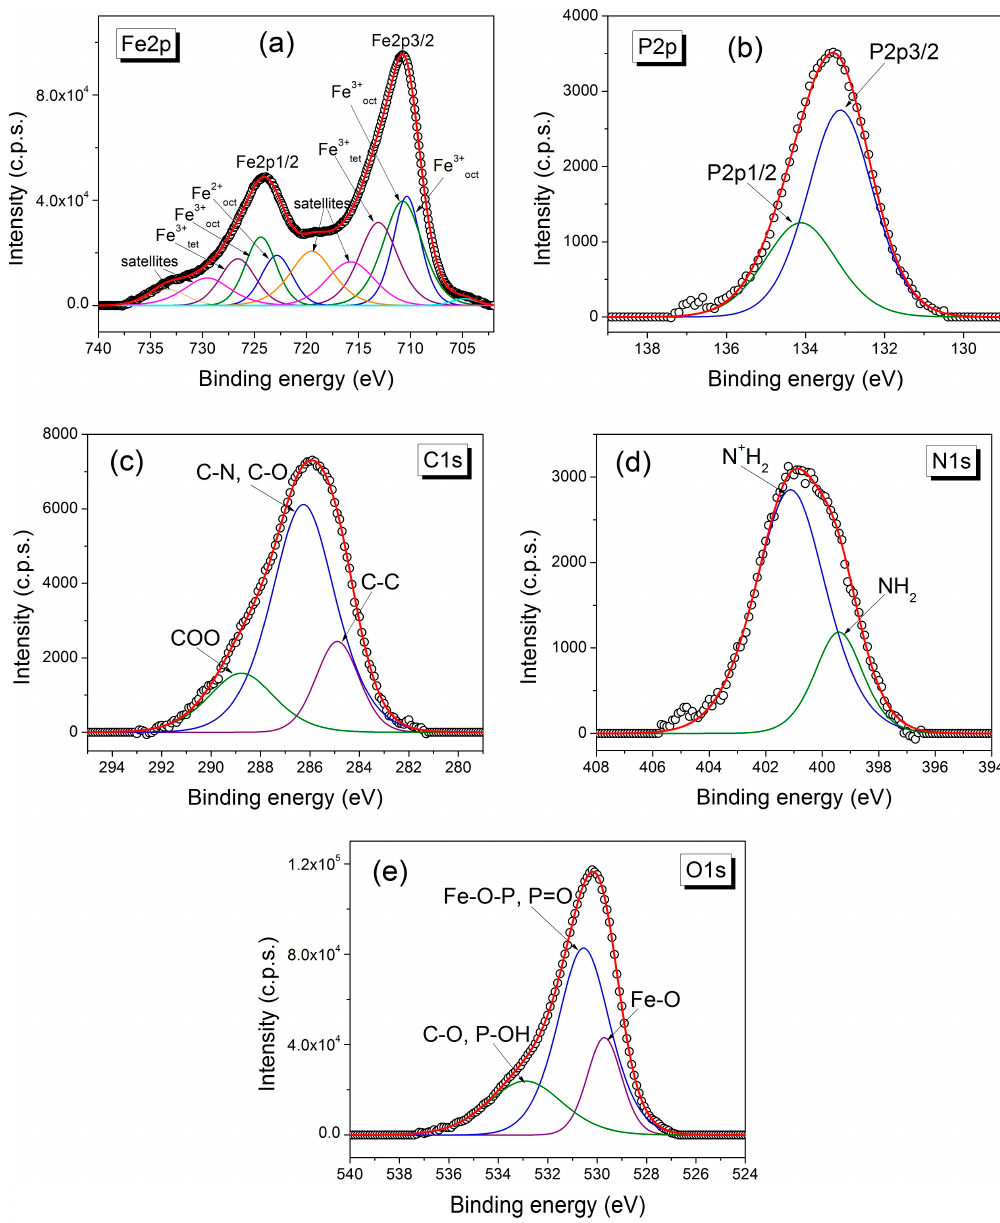
Figure 3. High resolution X-ray photoelectron spectroscopy XPS spectra of ( a ) Fe2p, ( b ) P2p, ( c ) C1s, ( d ) N1s, ( e ) O1s core-levels of magnetic nanoparticles 3a -3